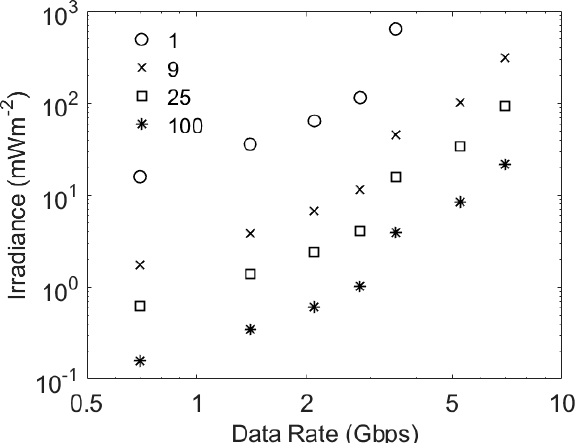
Figure 11. The potential performance of varying numbers of C10010 SiPMs working in parallel. These results were obtained using the same methodology as that used to obtained the results in Figure 9.